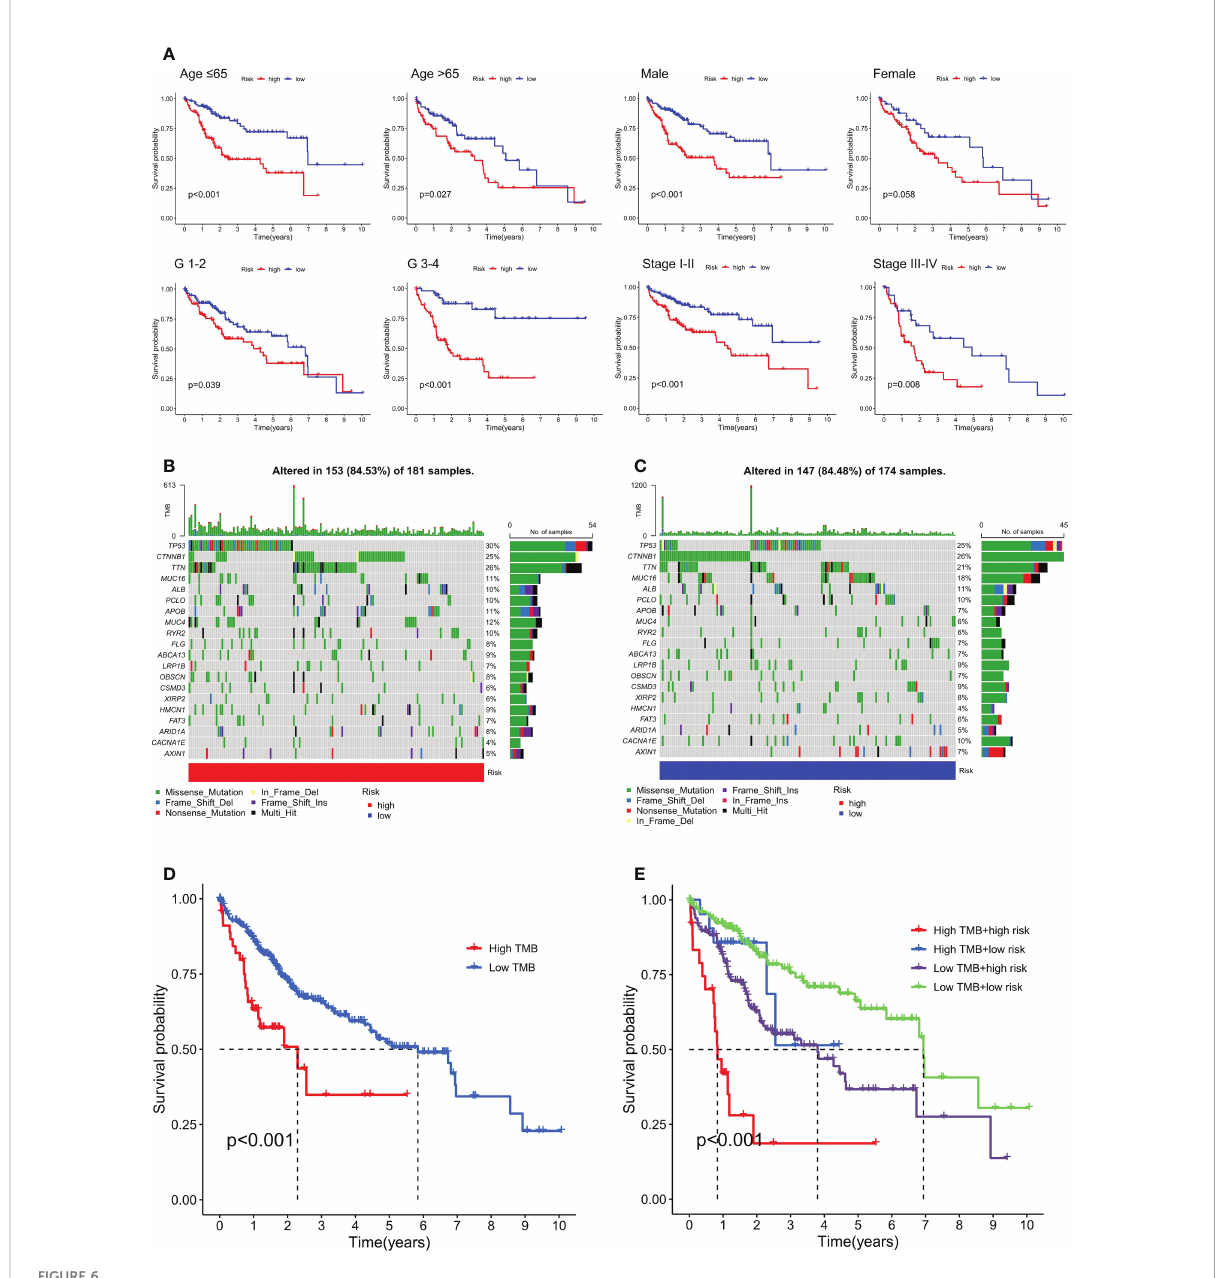
FIGURE 6 Kaplan-Meier curve analysis of OS in the low- and high-risk HCC patients on clinicopathological characteristics and TMB status. (A) Kaplan- Meier curve analysis of OS in the low- and high-risk HCC patients on clinicopathological characteristics (including age, gender, grade, and TNM staging). Waterfall plot of genes with high mutation frequencies in the high-risk group (B) and the low-risk group (C) . Kaplan-Meier curve analysis of OS based on TMB status (D) and both TMB status and risk scores (E)